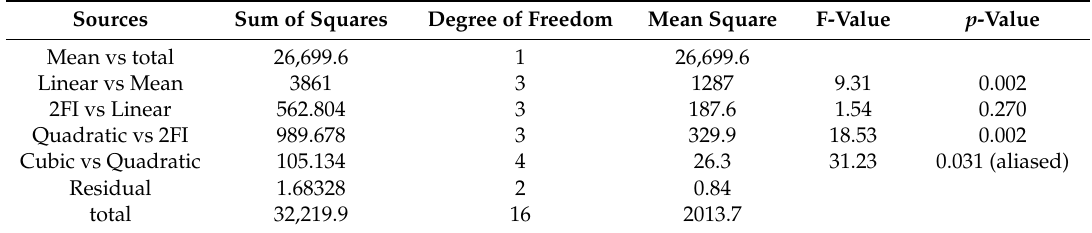
Table 4. Sequential model sum of squares for gloss.